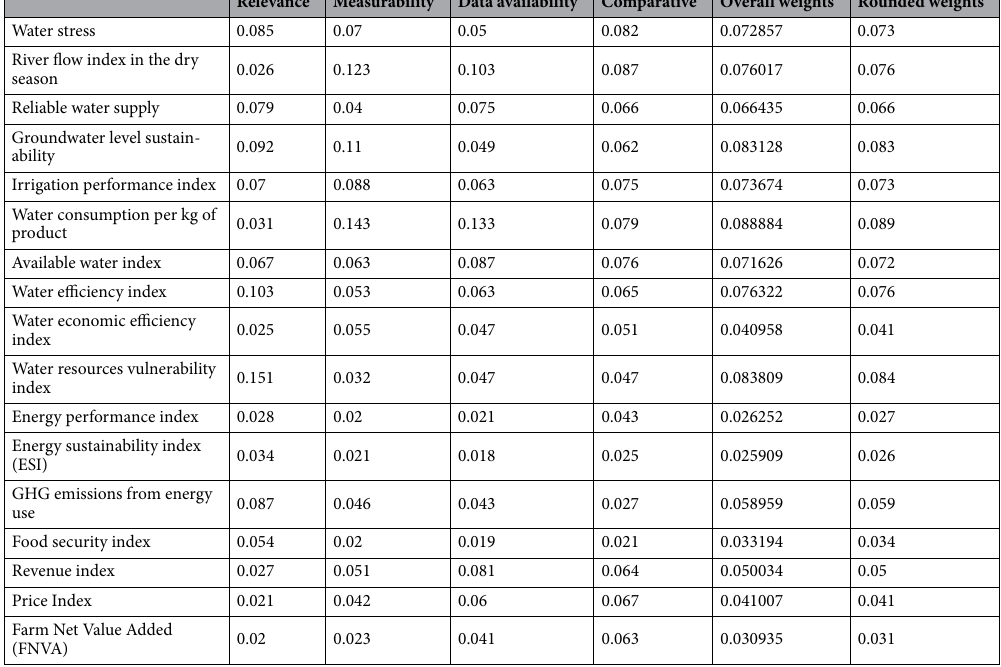
Table 4. Weights of the SPIs.